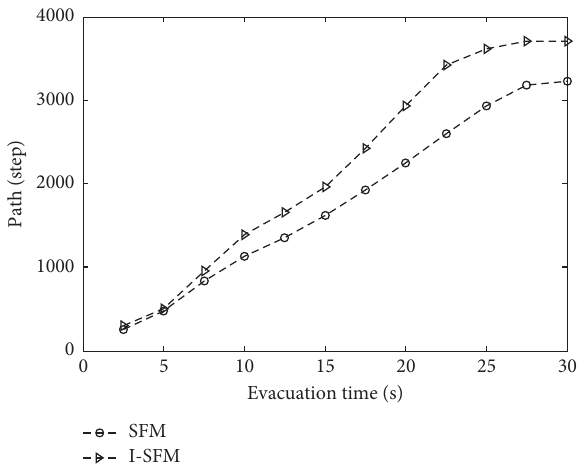
Figure 4: The relationship between the sum of pedestrian’s moving path length and the evacuation time.